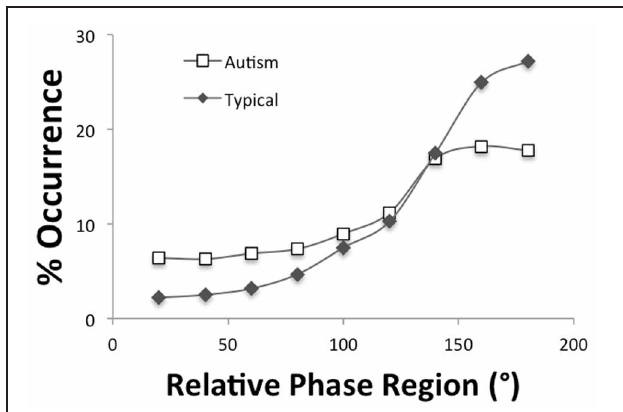
FIGURE 5 | Distributions of relative phase for antiphase drumming.